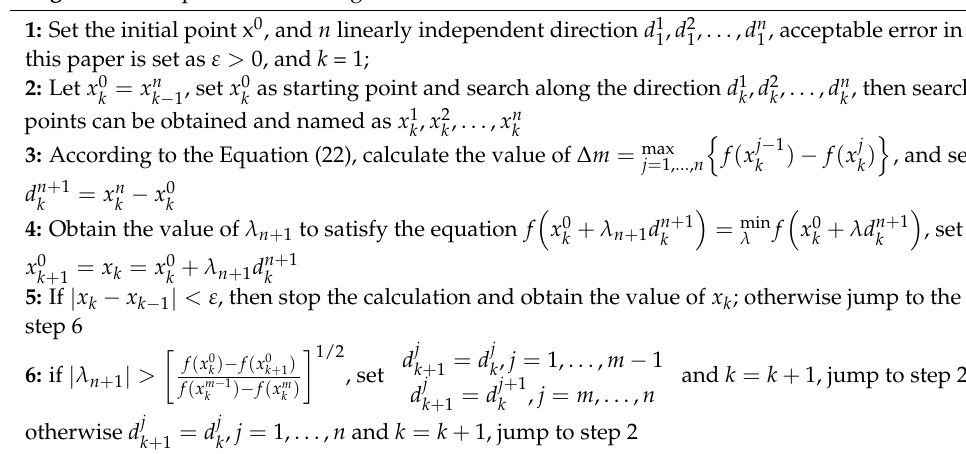
Algorithm 1 Improved Powell